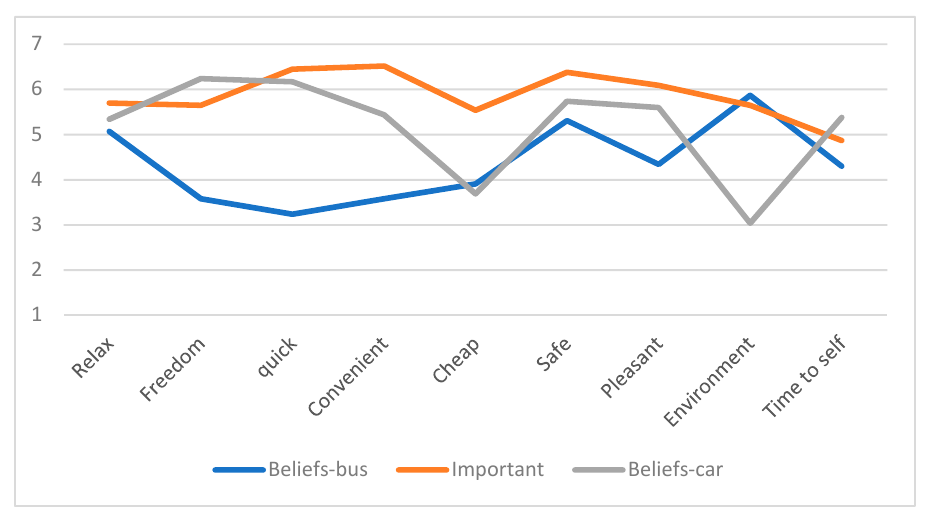
Figure 2. Importance and beliefs about a journey by car or bus (car users only).